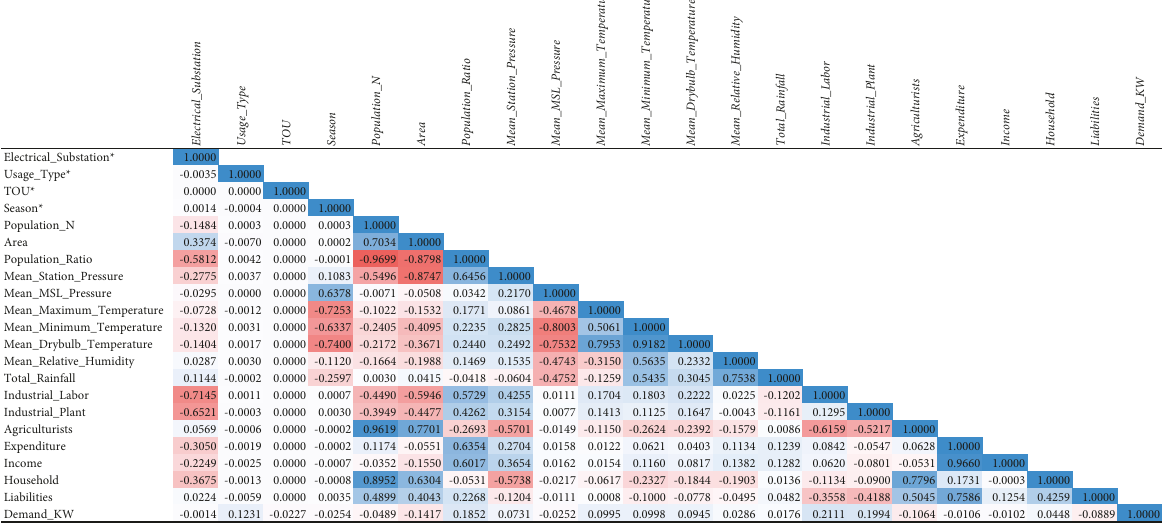
Spearman’s rank correlation ( r s )). ∗